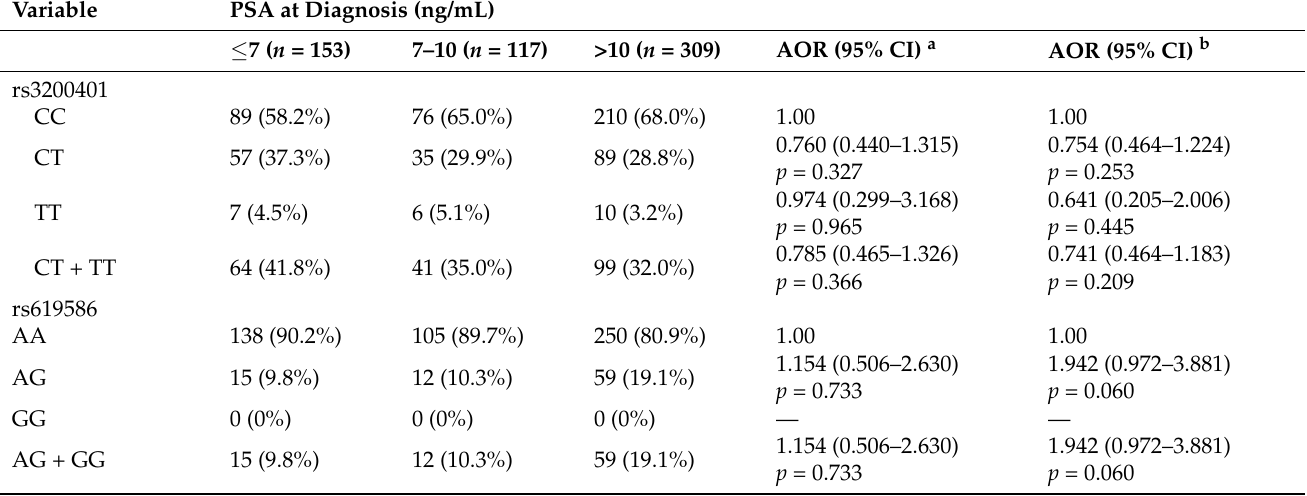
Table 2. Distribution frequency of MALAT1 genotypes in 579 patients with prostate cancer.